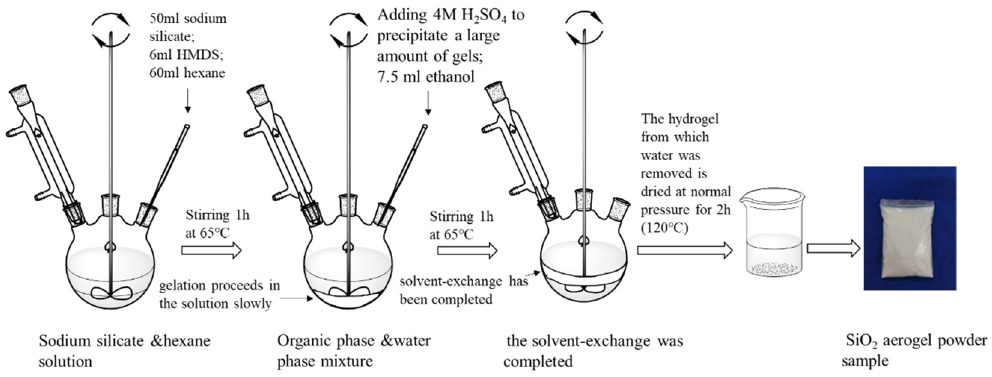
Figure 3. Sodium silicate was used as silicon precursor to synthesis SiO 2 aerogel powder by means of the one pot method.